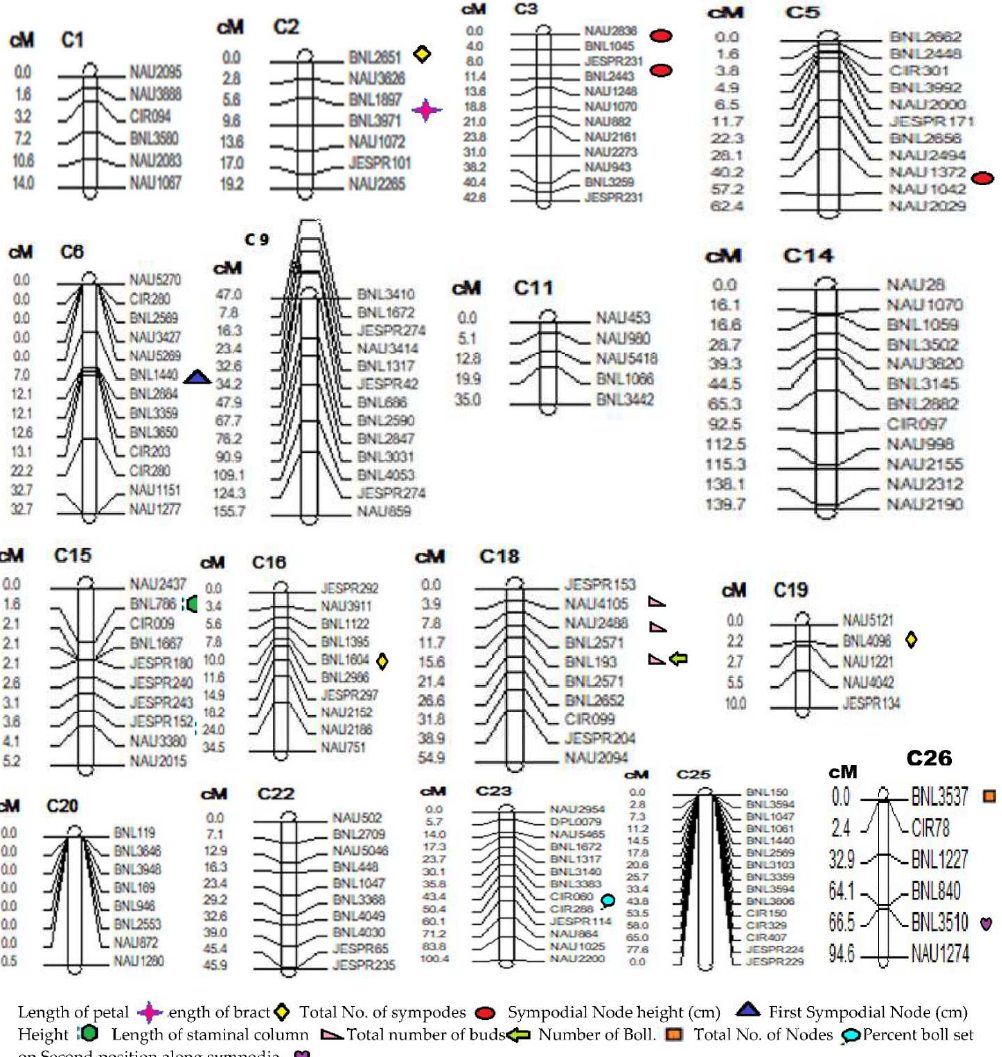
Figure 4. Linkage map and QTLs for heat stress tolerance determined in an F 2 population made from cross among Intraspecific MNH-886 and MNH-814 ( G. hirsutum ). The gap indicates that the linkage distance of the primer loci > 50 (cm) indicate significant QTLs (Kosambi). Table 5. Basic characteristics of the genetic map.